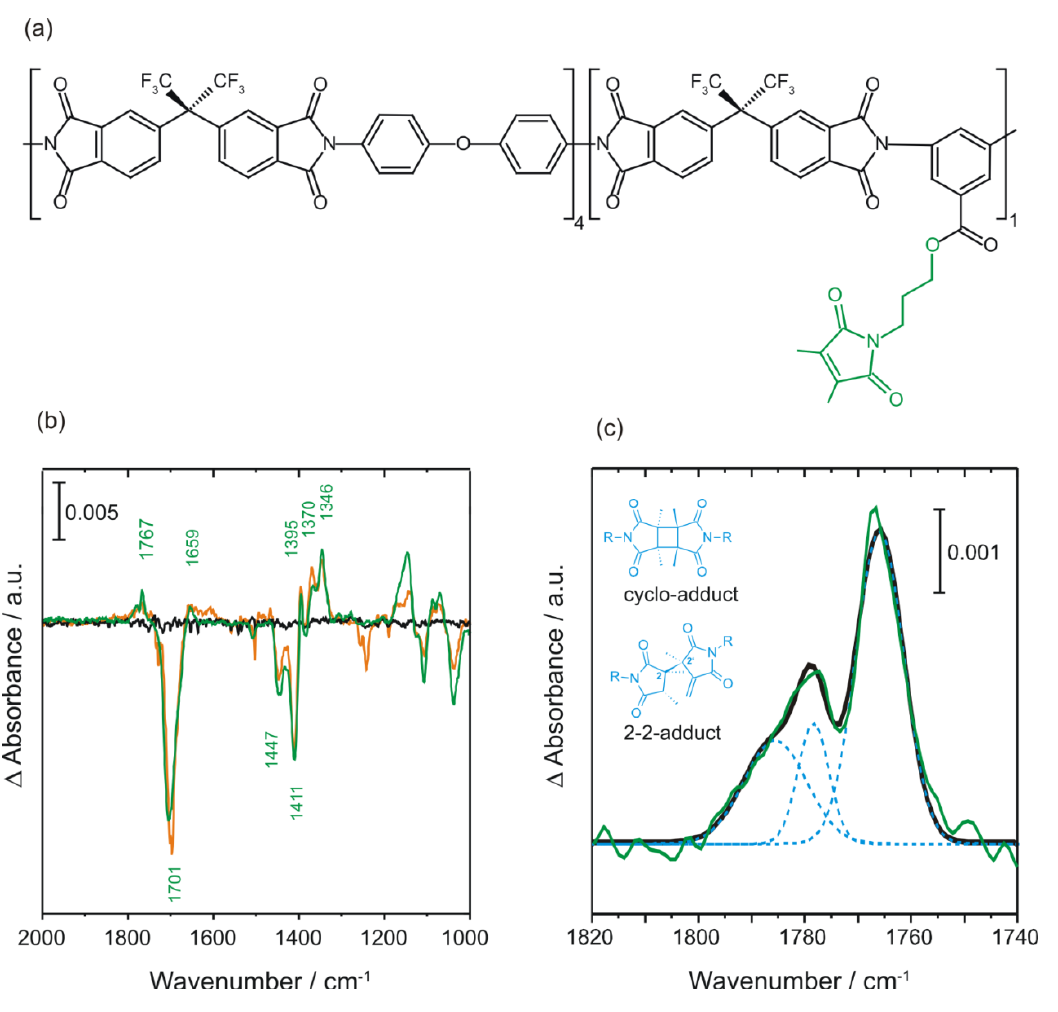
Figure 9. ( a ) Chemical structure of 6FDA-ODA/6FDA-DABA 4:1 copolyimide functionalized with 3-hydroxypropyldimetylmaleimide. Depicted in green is the maleimide side group; ( b ) Laser-induced FTIR difference spectra of 3-hydroxypropyldimethyl- maleimide (green), 6FDA-ODA/6FDA-DABA 4:1 copolyimide (black) and the copolyimide with 3-hydroxypropyldimethylmaleimide (green); ( c ) Difference spectrum of 3-hydroxypropyldimethylmaleimide (green) in the carbonyl region. The positive feature can be reproduced by the sum of three Gauss curves